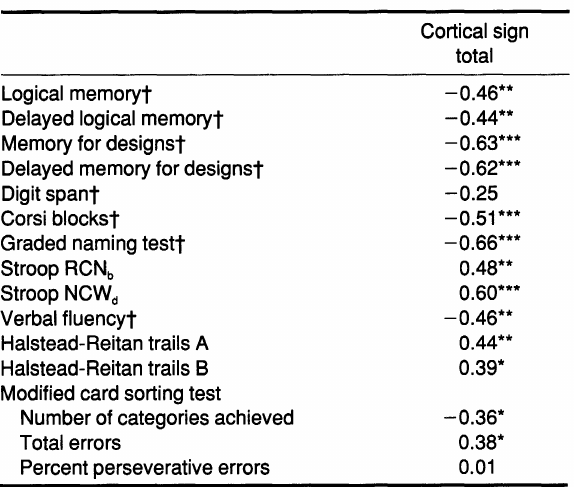
TABLE II. Correlations between cortical sign total score and neu ropsychological test